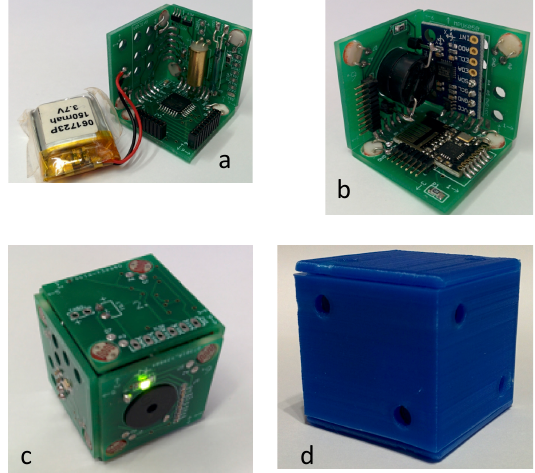
Figure 11. Picture of the cube. (a-b) two half-cube pieces; (c) assembling pieces; and (d) the cube with plastic housing.